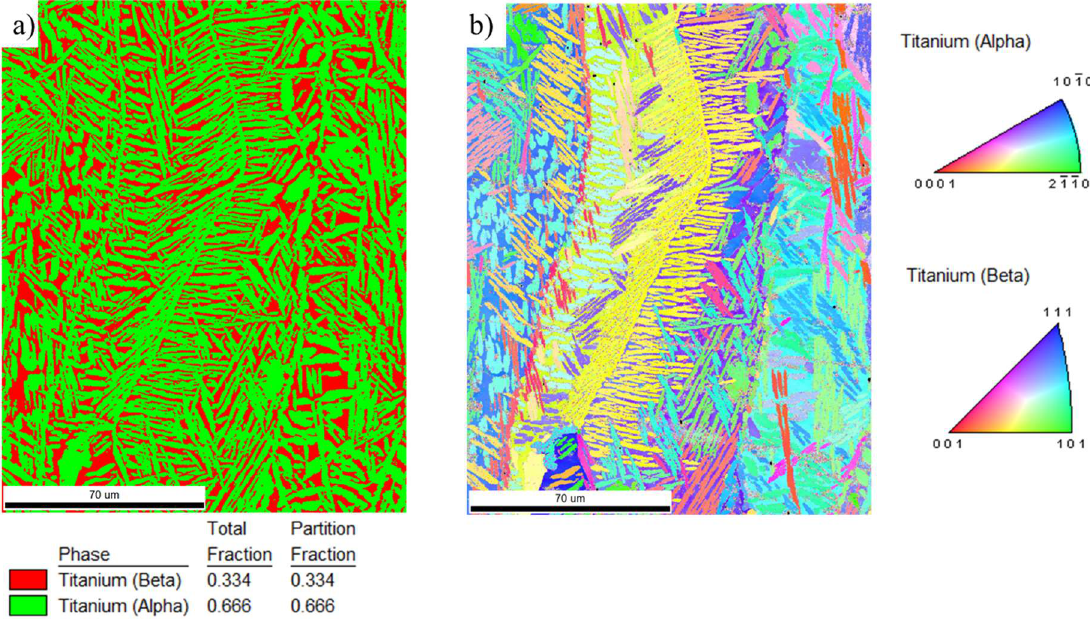
Figure 8. High-resolution EBSD ( a ) phase map and ( b ) IPF of EBM build sample.